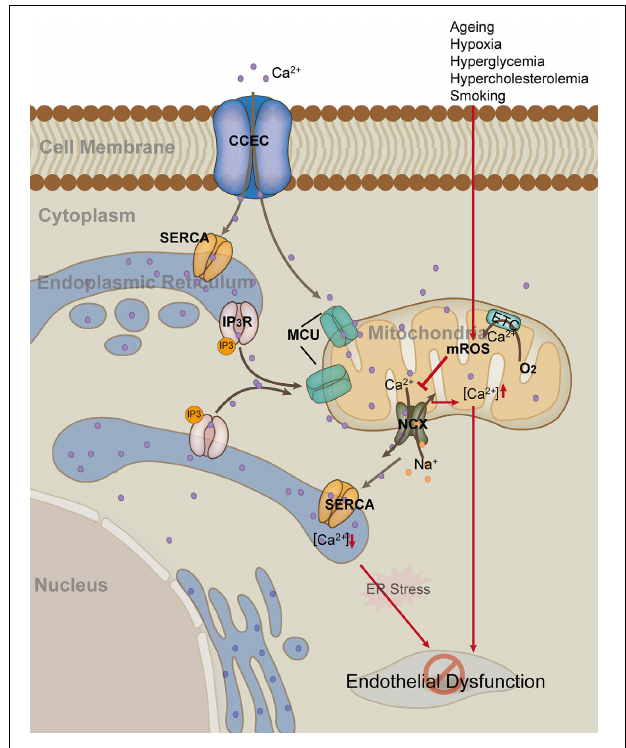
FIGURE 2 | Mitochondria in endothelial cell calcium hemostasis. Endothelial cells uptake Ca 2 + through the membrane capacitative Ca 2 + entry channel (CCEC). Generally, endoplasmic reticulum (ER) and mitochondria uptake Ca 2 + through sarco/ER Ca 2 + -ATPase (SERCA) and mitochondrial Ca 2 + uniporter (MCU), respectively. Inositol 1,4,5-triphosphate (IP3) can activate the release of Ca 2 + from ER by binding to IP3 receptor on the membrane of ER. In contrast, mitochondria release Ca 2 + and at the same time uptake Na + through the Na + /Ca 2 + exchanger (NCX). Risk factors such as hypoxia and hyperglycemia, up-regulate mROS production, which in turn inhibits the activity of mitochondrial NCX, leading to elevated level of [Ca 2 + ] m and decreased level of [Ca 2 + ] e . Persistent high level of [Ca 2 + ] m and low level of [Ca 2 + ] e result in mitochondria damage and ER stress, as well as subsequent endothelial dysfunction (Red